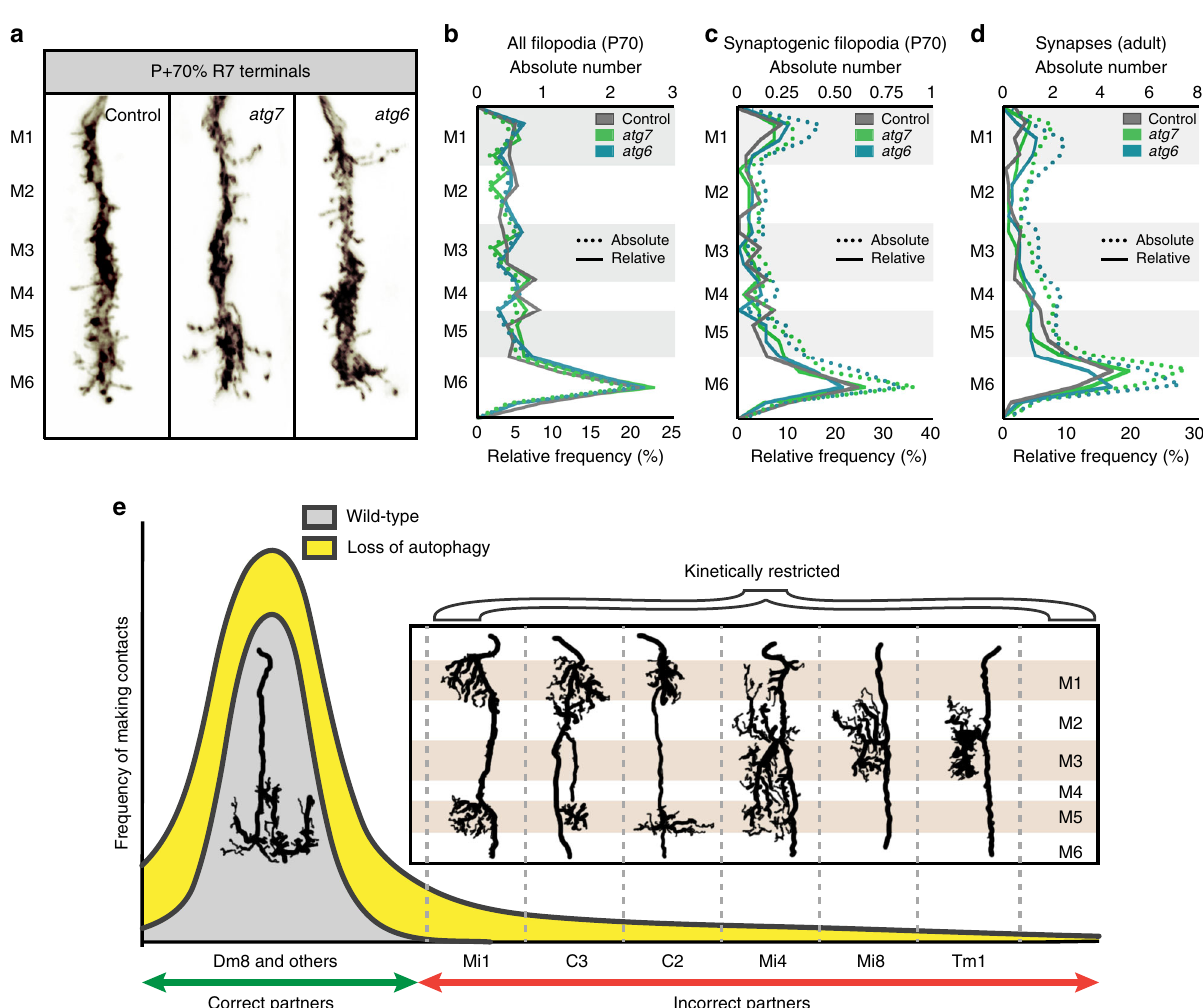
Fig. 7 Loss of autophagy recruits incorrect synaptic partners by lowering an axon terminal-wide threshold for kinetic restriction of synapse formation. a Representative R7 axon terminals at P + 70% with medulla layer information. Note that the edge of medulla (M0) is de fi ned as 0 and the end of M6 layer is de fi ned as 100 to calculate relative positions of all fi lopodia and bulbous tip fi lopodia, and distributed to medulla layers (M1 – M6) using the relative thickness of medulla layers de fi ned by Fischbach and Dittrich 46 . Repeated fi ve to ten times independently with similar results. b – d Relative frequency (solid lines) and absolute numbers (dotted lines) of all fi lopodia at P + 70% ( b ), synaptogenic fi lopodia at P + 70% ( c ), and synapses at 0-day-old adult ( d ). M1 – M6 denote medulla layers. n = 40 terminals per condition. e Model: loss of autophagy during synaptogenesis increases the probability distribution (yellow area) compared with wild-type (gray area) of forming connections with postsynaptic partners through increased fi lopodial stability. Note that cells with projections at medulla layers where R7s form most of their synapses (Mi1, Mi4, C2, C3) incorrectly synapse with R7s, with higher probability than the cells with projections at medulla layers where R7s form a few, if any, synapses (Mi8, Tm1) (see Fig. 3e, f). Redrawn and adapted based on Golgi impregnations from Fischbach and Dittrich 46 . Source data are provided as a Source Data fi